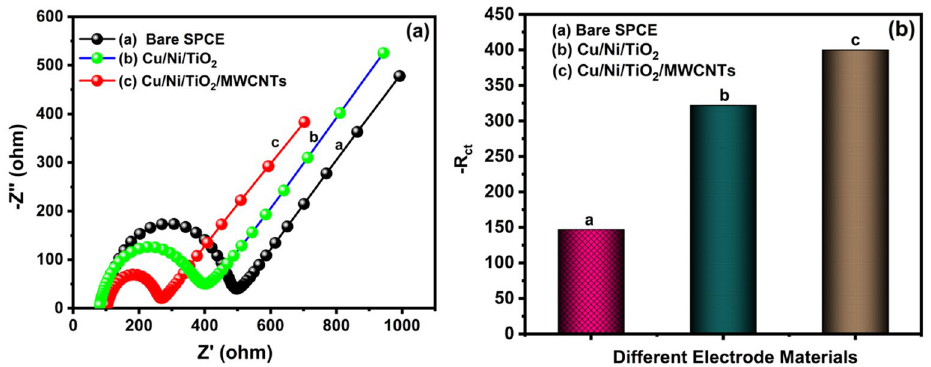
Figure 5. ( a ) EIS analysis of bare SPCE and Cu/Ni/TiO 2 /MWCNTs nanocomposites fabricated electrode in 0.1 M KCL at 5 mM [Fe (CN) 6 ] 3−/4− . ( b ) R ct values of bare SPCE and Cu/Ni/TiO 2 /MWCNTs nanocomposites fabricated electrode.